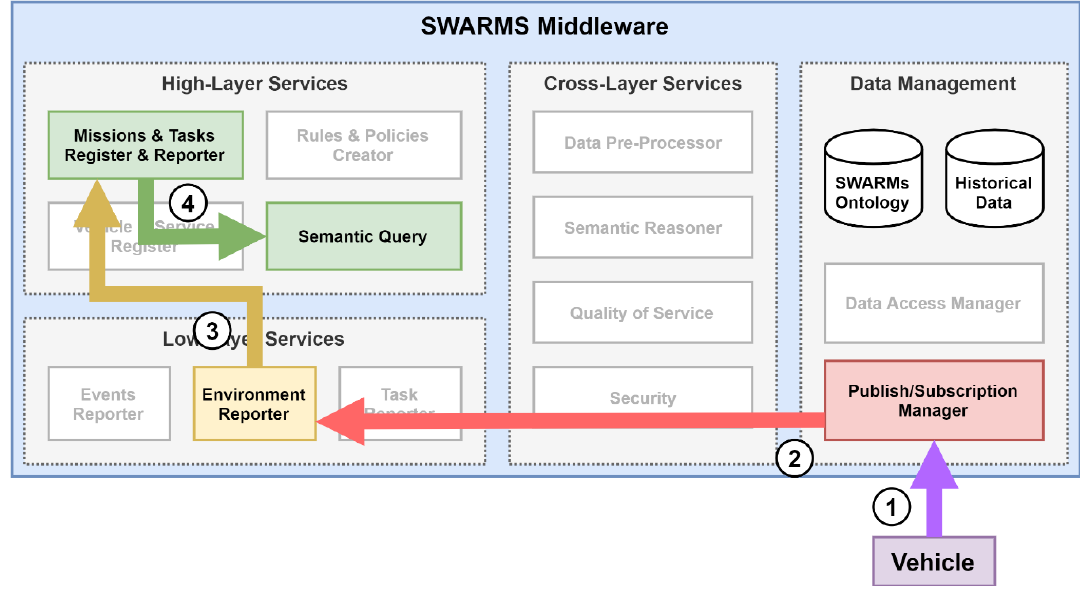
Figure 18. Functional overview of the processing of an environmental report.